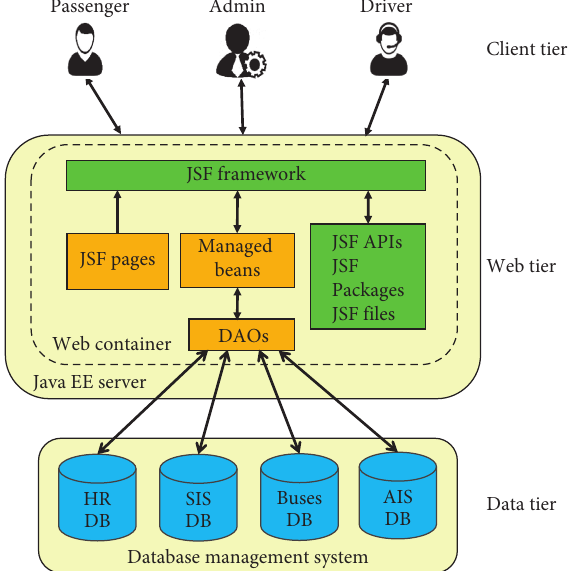
Figure 14: The three-tier architecture of the bus management